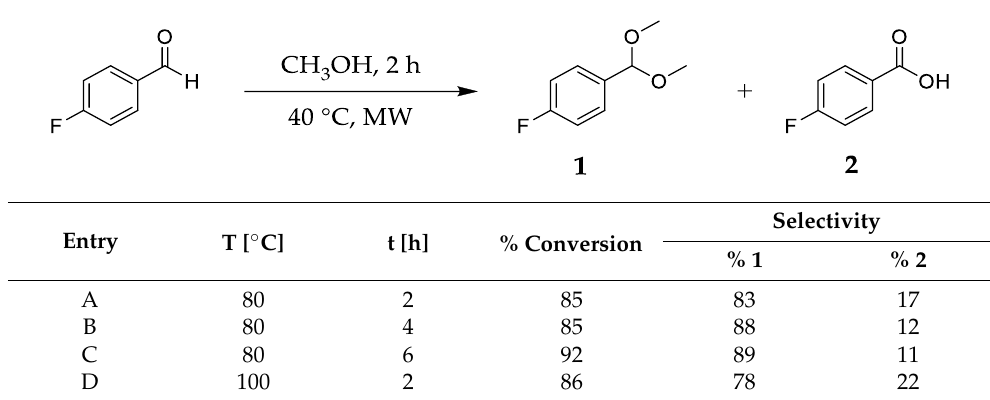
Table 12. Results of the reusability tests conducted with CNS-Zn a .